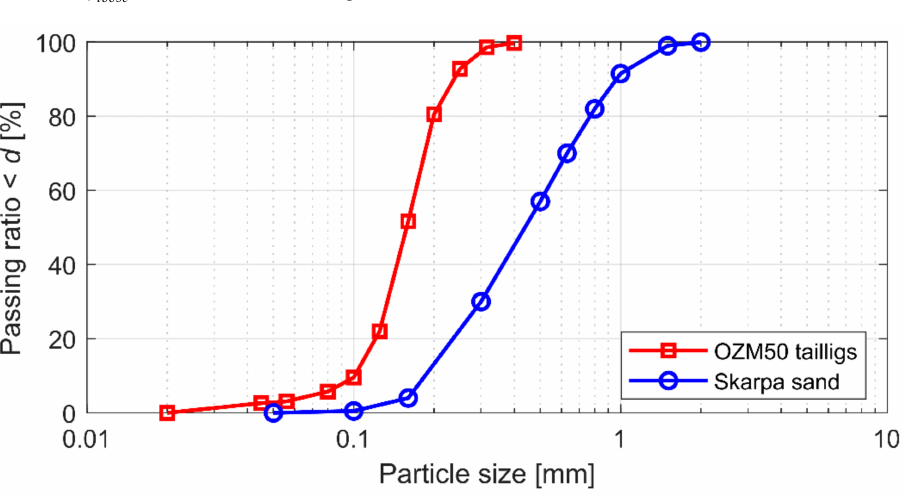
Figure 5. Particle size distribution curves of tested soils.